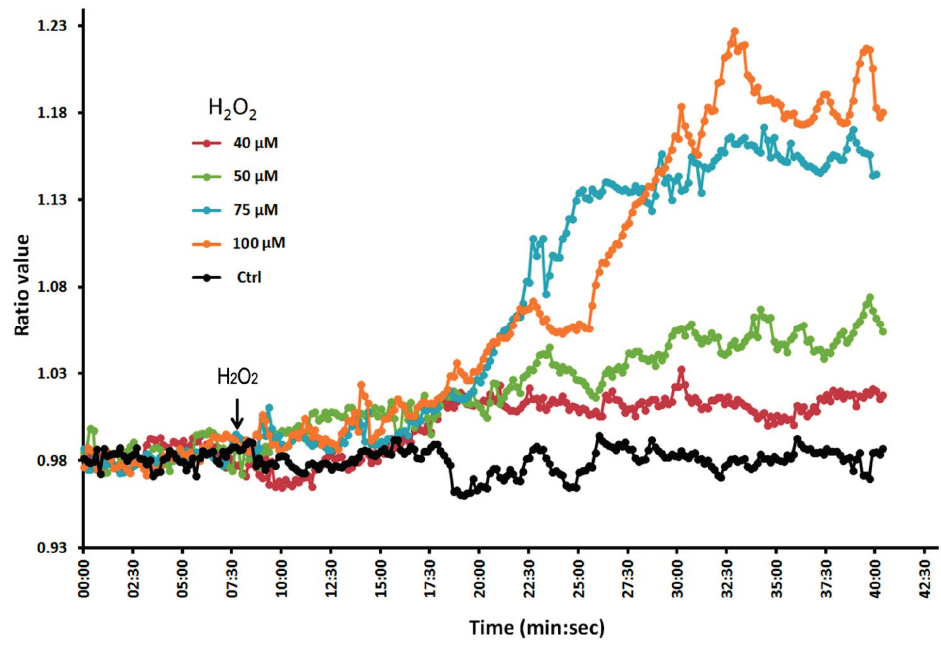
Figure 2. Increased levels of external H 2 O 2 result in increased intracellular changes in ratio values. Arabidopsis roots expressing Hyper were treated with different external concentrations of H 2 O 2 and the intracellular changes were monitored by analyzing Hyper fluorescence ratios. Images were acquired at 10 s intervals. Note that higher concentrations of external H 2 O 2 resulted in increased ratio